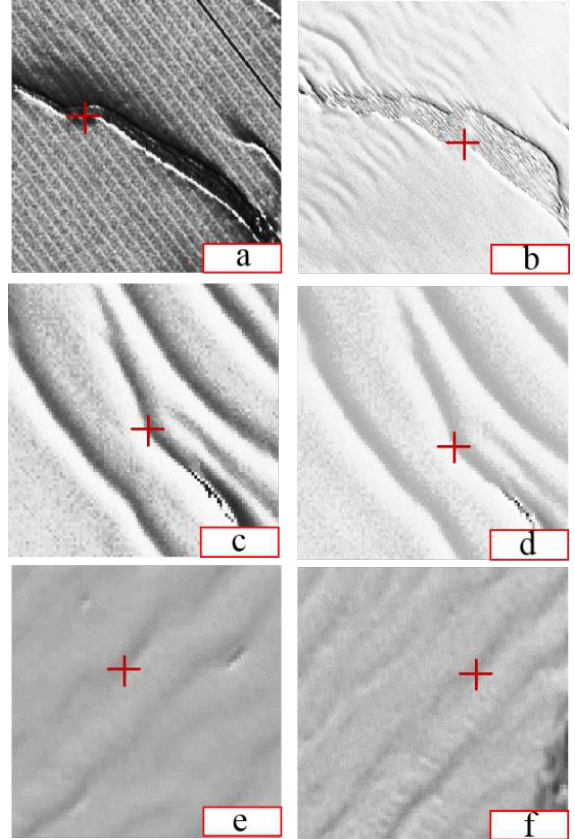
Table 1. Data sources in the study